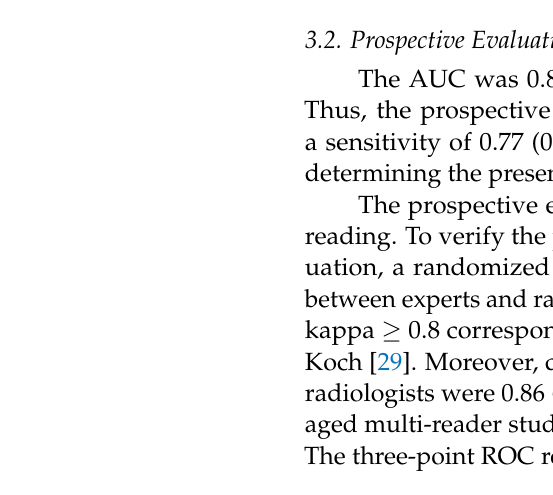
Table 3. The human and AI system diagnostic performance metrics: prospective